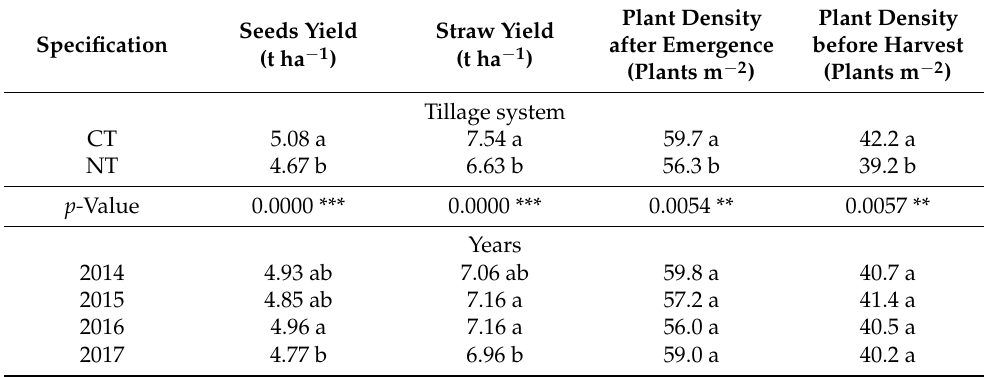
Table 1. Yield of seeds and straw as well as winter oilseed rape plant density depending on the tillage system (mean for 2014–2017) and research